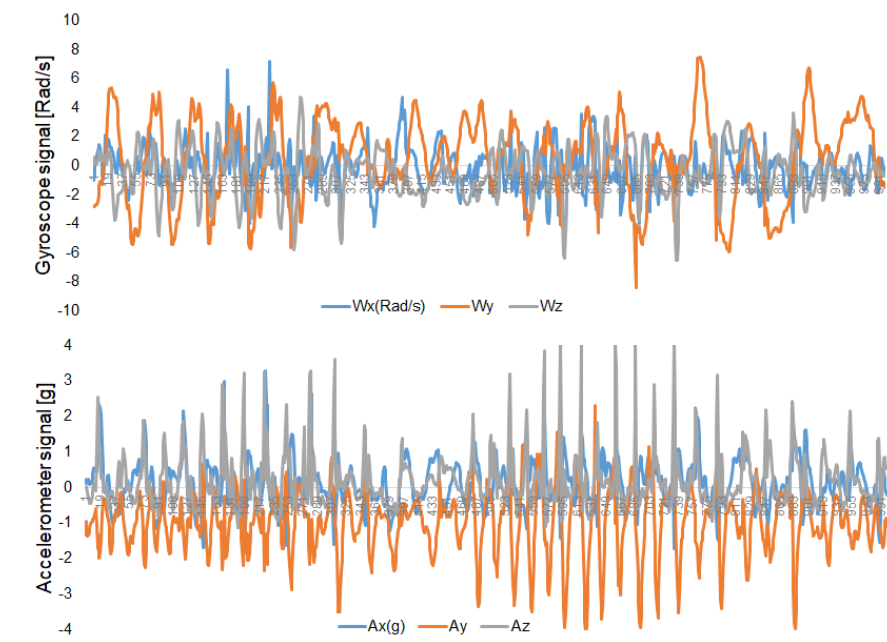
Figure 6. Examples of test signal sequences for gyroscope data, and accelerometer